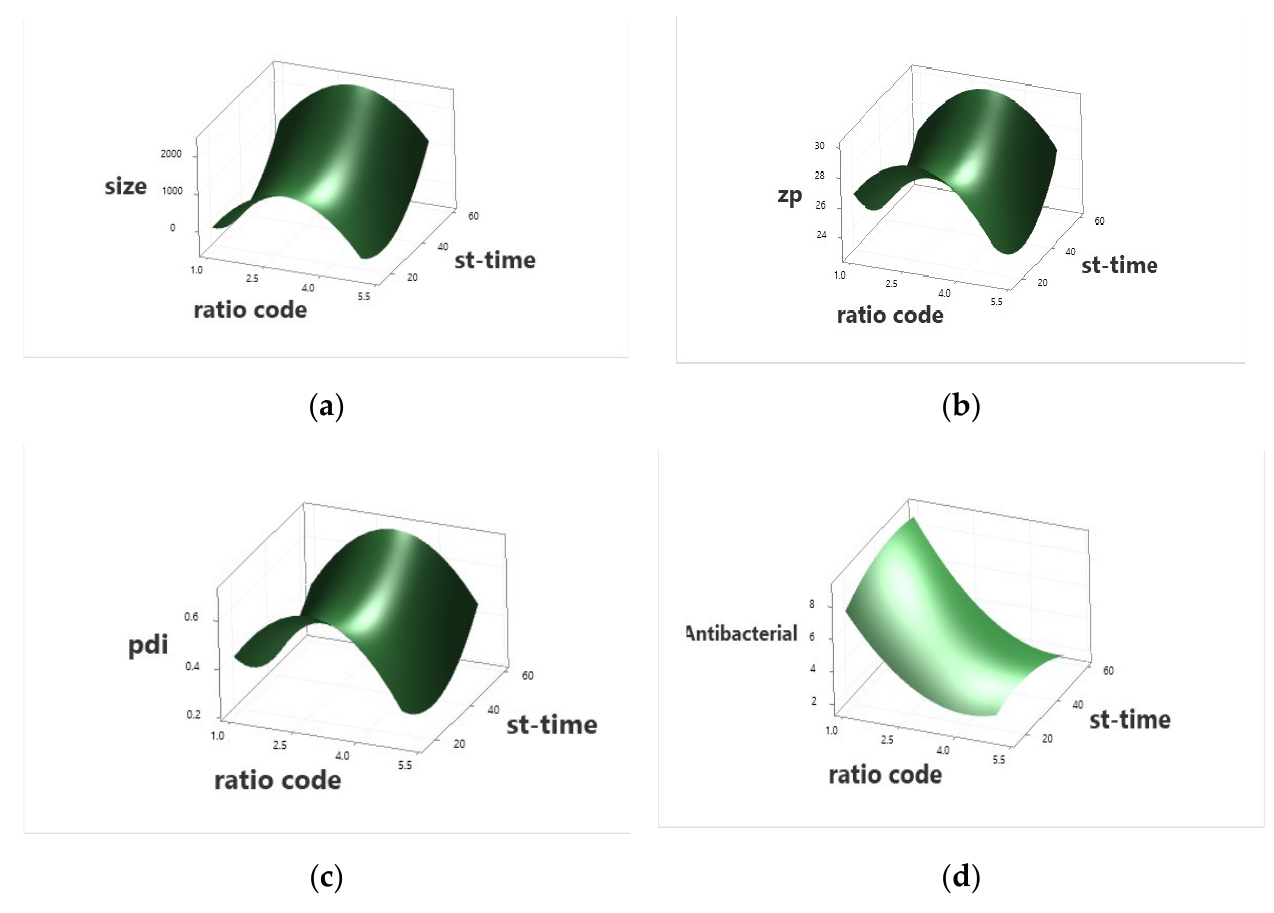
Figure 2. Surface plot of the nanoparticles’ different levels of stirring time and P/SE ratio in response to size ( a ), zeta potential ( b ), PDI ( c ) and antibacterial activity ( d ).